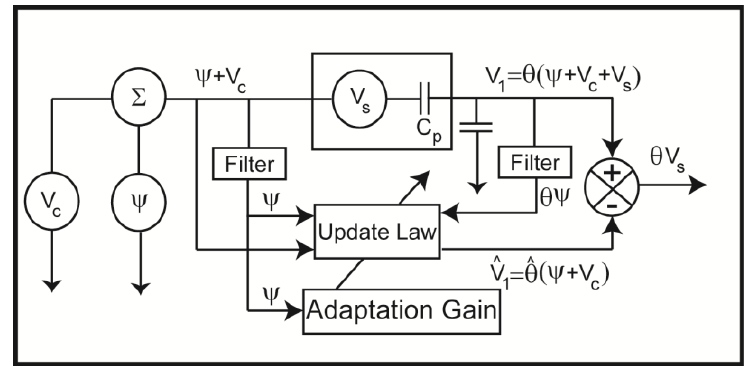
Figure 6. Schematic of the adaptive self-sensing